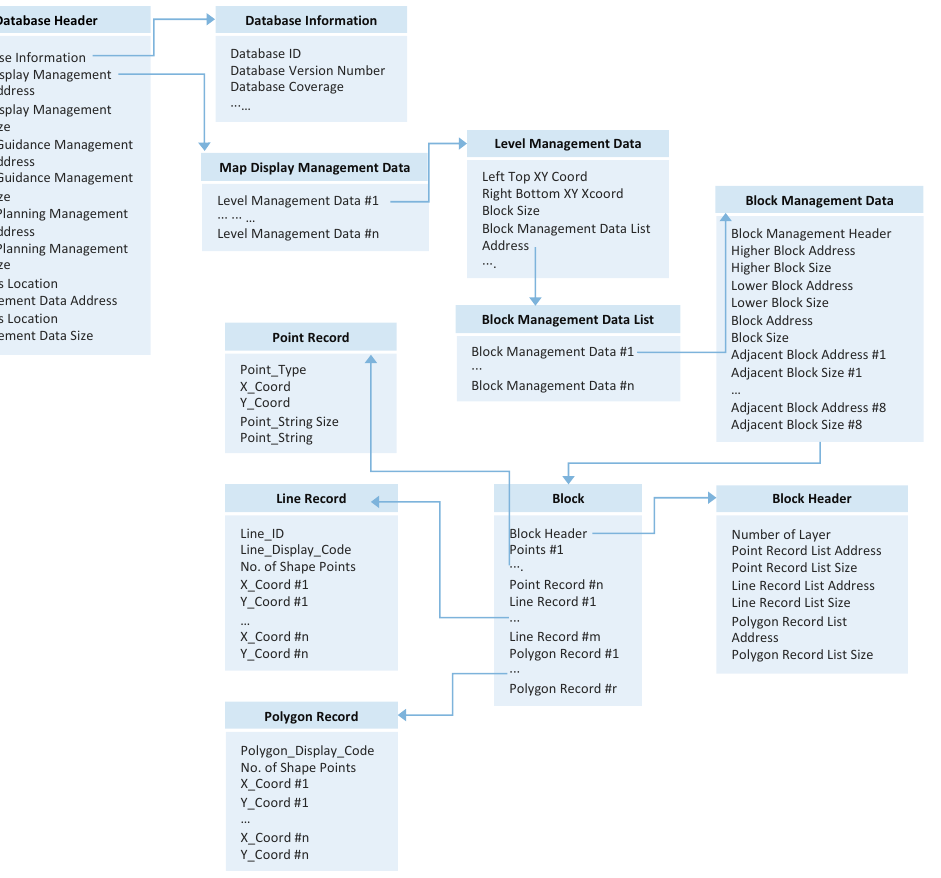
Figure 2. UML Class diagram of GIS DB.